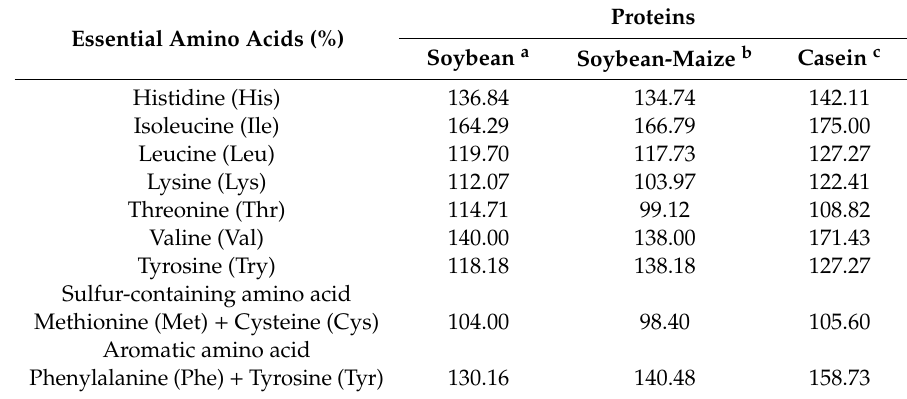
Table 3. The amino acid score of soybean, soybean-maize and casein proteins 1